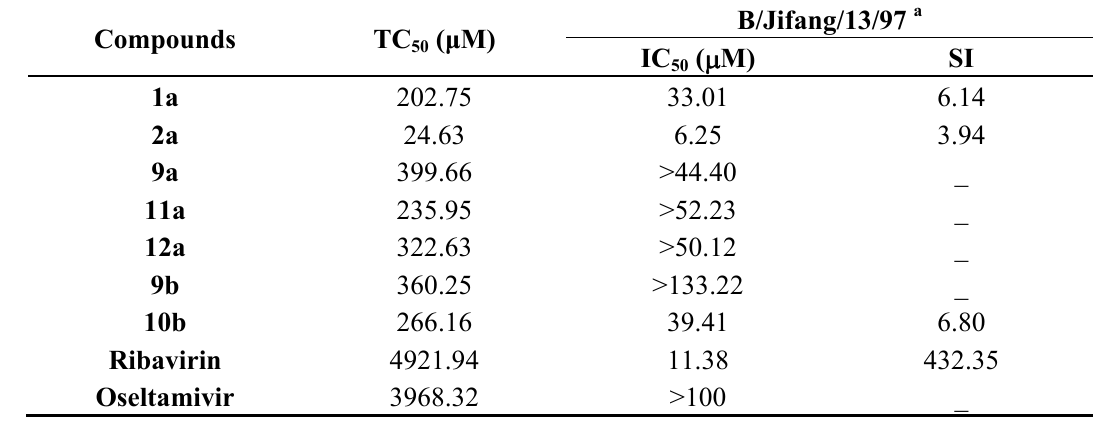
Table 2. Activities of the synthesized compounds against the oseltamivir-null influenza